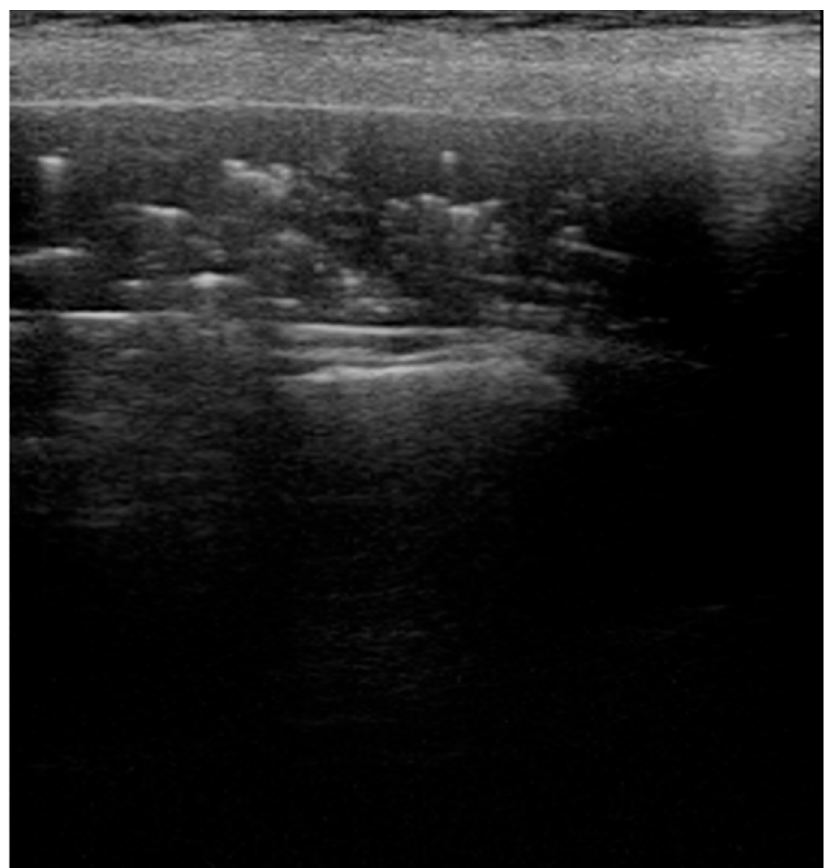
Figure 5. Atelectasis in a patient with neuromuscular disease: presence of static horizontal bron- chograms that do not move with respiration.